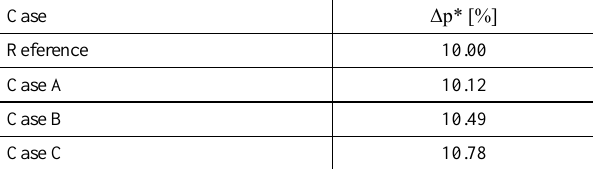
Table 5. The total pressure drop in the